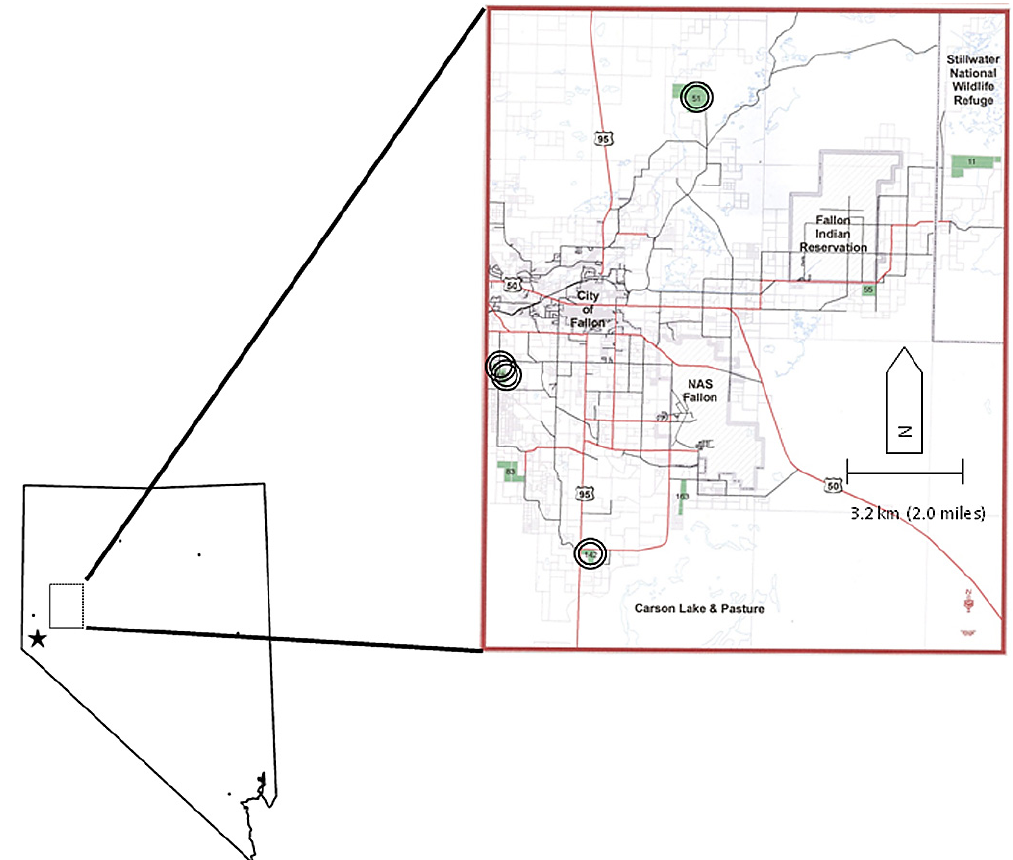
Figure 1. Location of study area, with locations of test wells indicated in